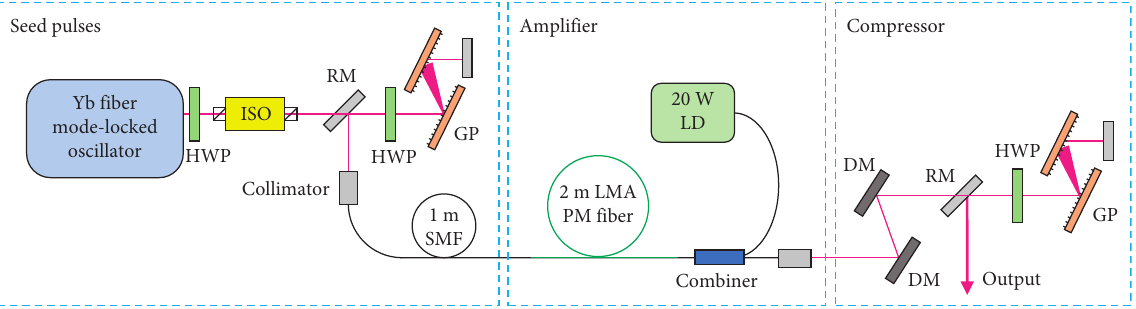
Figure 1: Schematic of the experimental